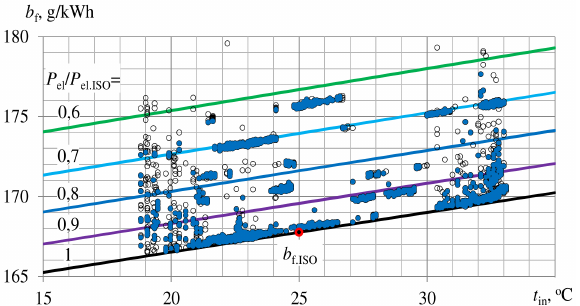
Figure 7. Variation of mass-specific fuel consumption b f against inlet air temperature t in at various loads P el /P el.ISO , P el —electrical power as monitored data; P el.ISO —rated electrical power at ISO ambient air parameters: t amb = 25 ◦ C, and relative humidity ϕ amb =